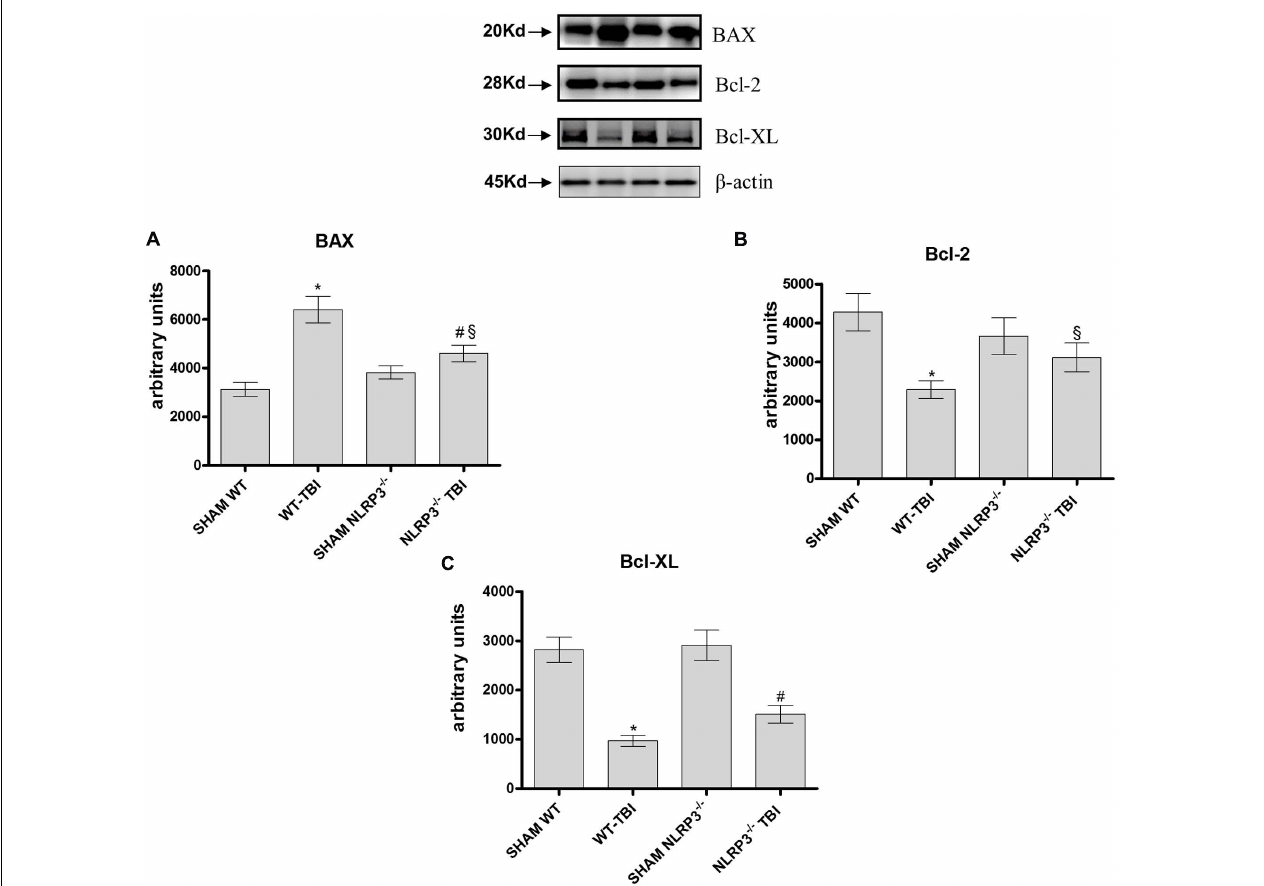
FIGURE 6 | Representative western blot of Bax, Bcl-2 and Bcl-xl at dat 7. The graphs represent the quantification of Bax (A) , Bcl-2 (B) , and Bcl-xl (C) . ∗ p < 0.05 vs Sham WT; # p < 0.05 vs Sham NLRP3 - / - ; § p < 0.05 vs WT-TBI. Each bar represents the mean and SD of seven animals.